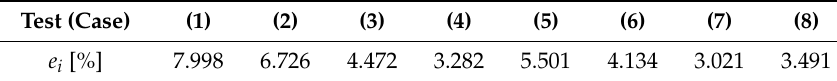
Table 1. Quality indicators of the stator current estimation.